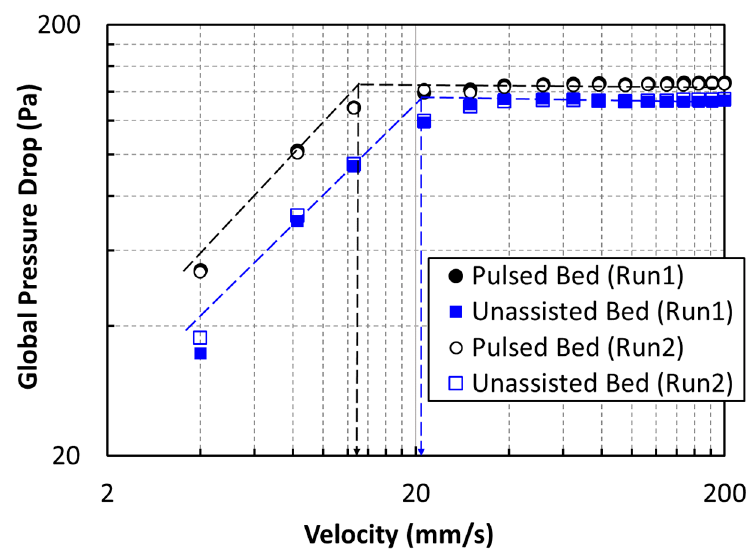
Figure 12. Global pressure drop variation with velocity for the defluidization cycle of experiments for determining U mf .